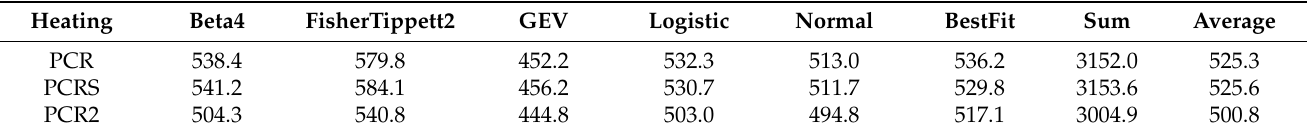
Table 3. Results of the mean absolute errors of heating energy use probability density functions stemming from each input principal component variable distribution series for PCR, PCRS and PCR2 regression